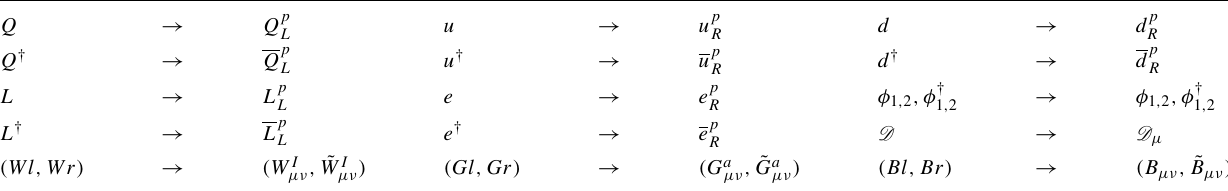
Table3 DictionaryfortranslationofoperatorsfromtheHilbertSeriestotheircovariantforms.Thetranslationfromtheform( Fl , Fr )to( F μν , ˜ F μν ) is accomplished using Eq. (108)